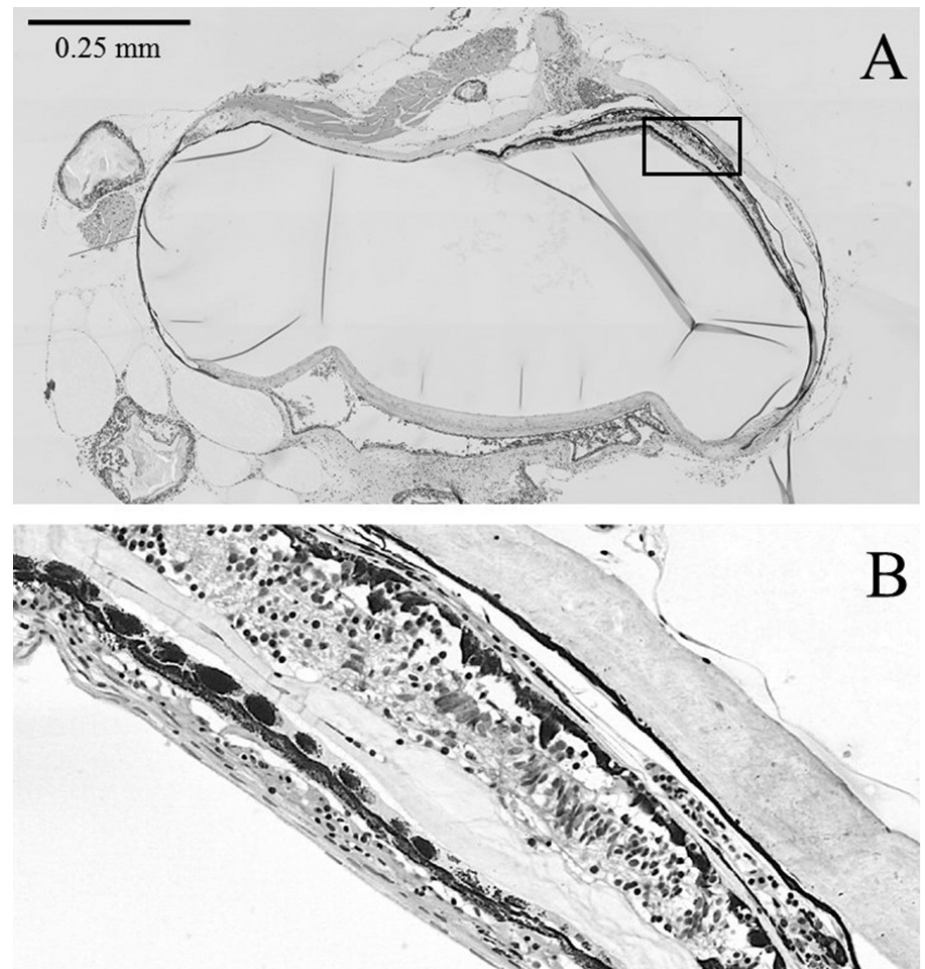
Figure 5. Eye histology in one of the fish with most degenerated eyes. A eye capsule. Notice the absence of lens. B retina. Notice the high disorganization of vestigial layers, which are for the most part unrecog- nizable when compared to surface fish retinal